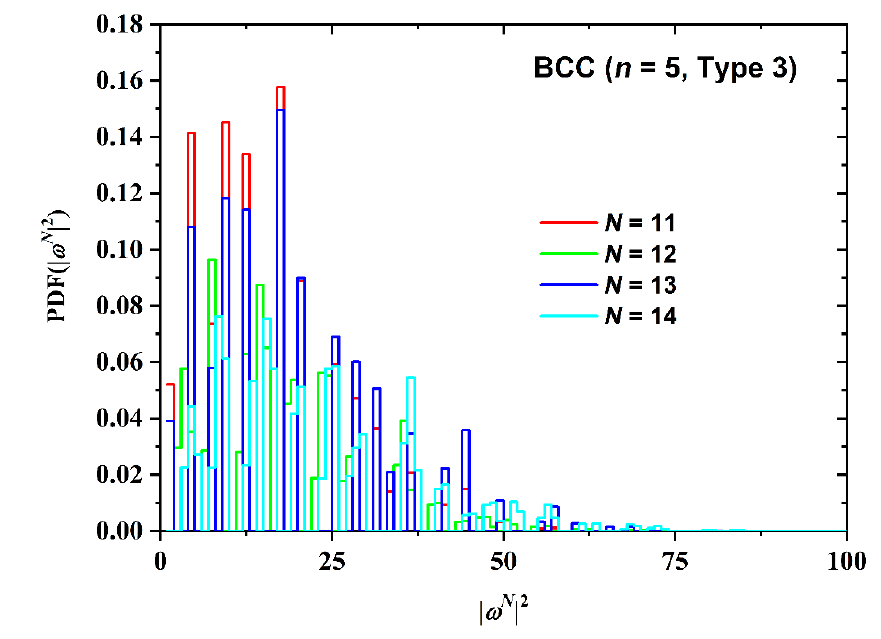
Figure 13 . Probability distribution function (PDF) of the square end-to-end distance for the BCC restricted lattice for SAWs of fixed number of layers between confining plates ( n = 5) and point of origin (Type 3). Different curves correspond to different number of SAW steps, N .